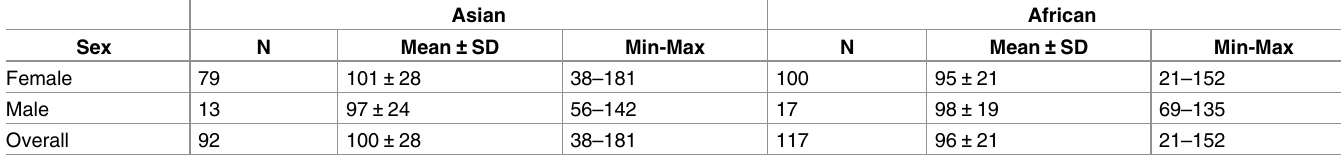
Table 3. Mean ± SD and range of glucose concentrations (mg/dl) in male and female Asian and African